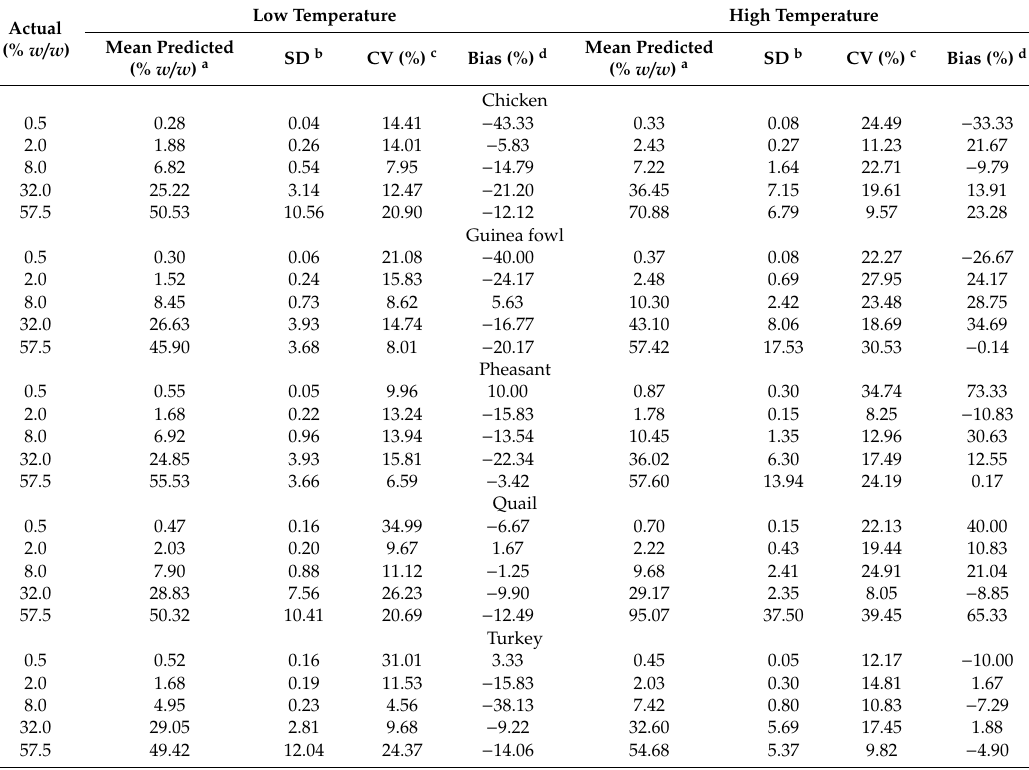
Table 4. Predicted concentrations of meat from five poultry species in unknown emulsified type sausages under two temperature conditions, quantified with reference